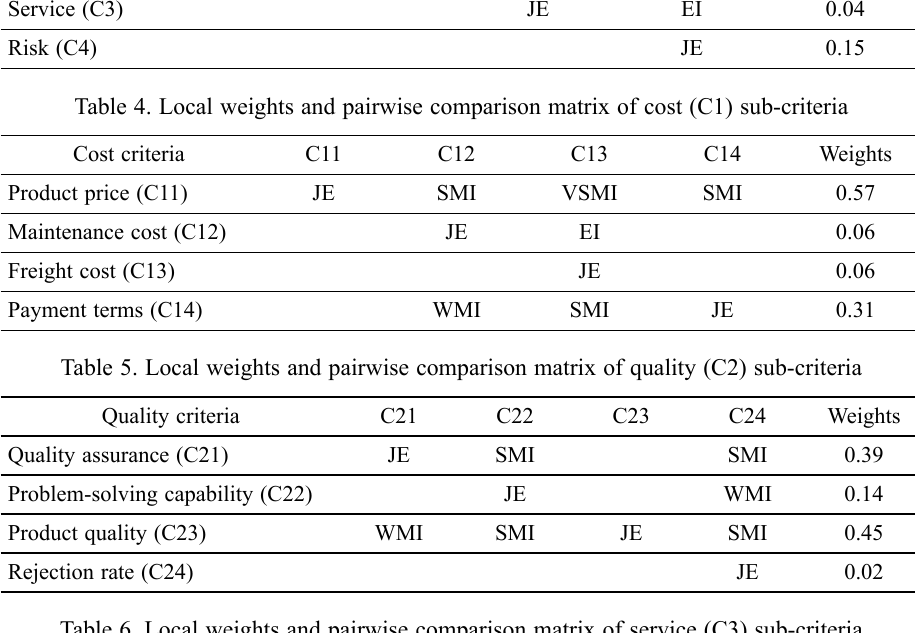
Table 6. Local weights and pairwise comparison matrix of service (C3)